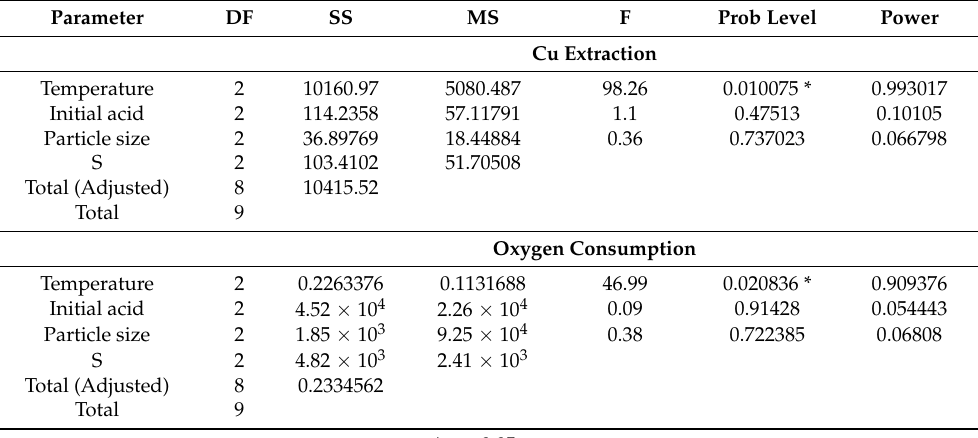
Table 9. Analysis of variance (ANOVA) for Cu